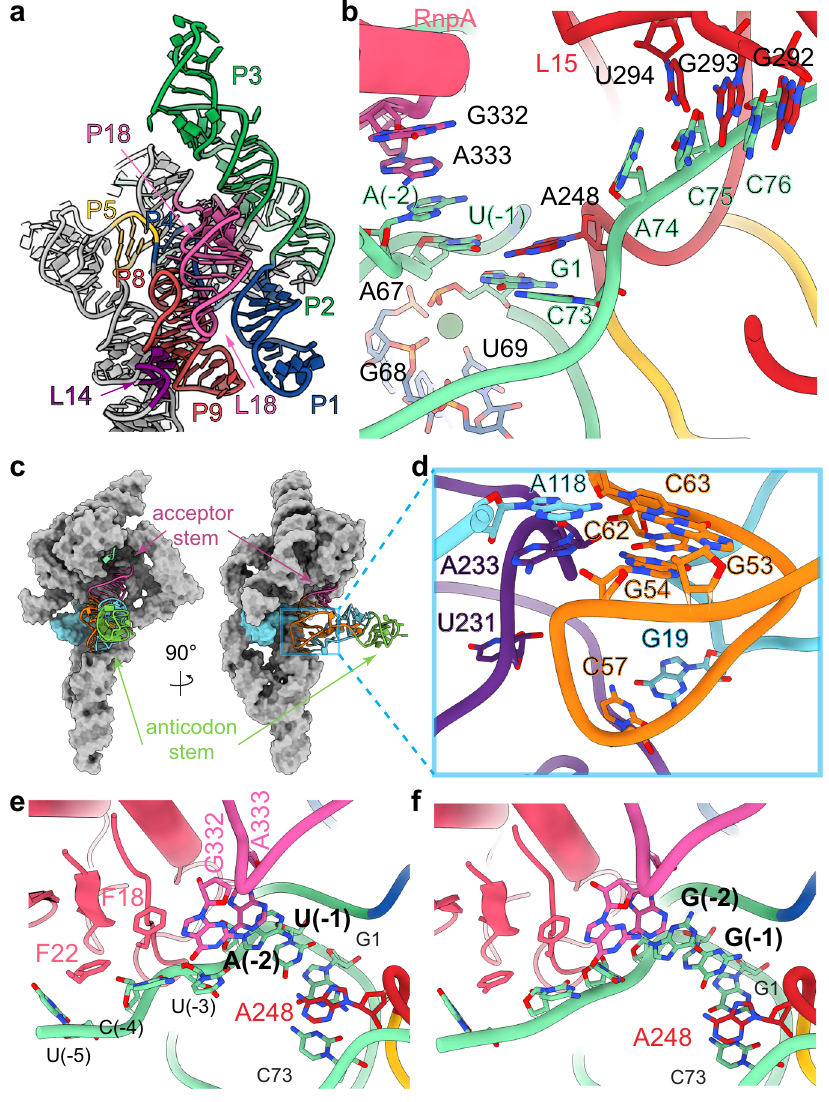
Fig. 4 | CryoEM structures of ES* complex of ptRNA_AU and ptRNA_GG and E. coli RNase P. a Colored structure model highlighting three sets of coaxial stacked helices P2 – P3 (green), P1 – P4 (blue), P5 (yellow) and P8 – P9 (cyan) as well as tetraloop-helix interactions between L14 (purple), L18 (pink) and P8 – P9 (red). b Overall view of the active site in ptRNA_AU bound E. coli RNase P structure showing interactions between P RNA and rnpA (pink) with the ptRNA 5 ′ leader sequence (green) and base pairings between ptRNA 3 ′ ACC and G292-U294 of L15 internalloop.Aninner-sphereCa 2+ coordinatesphosphategroupsofA67,G68,and